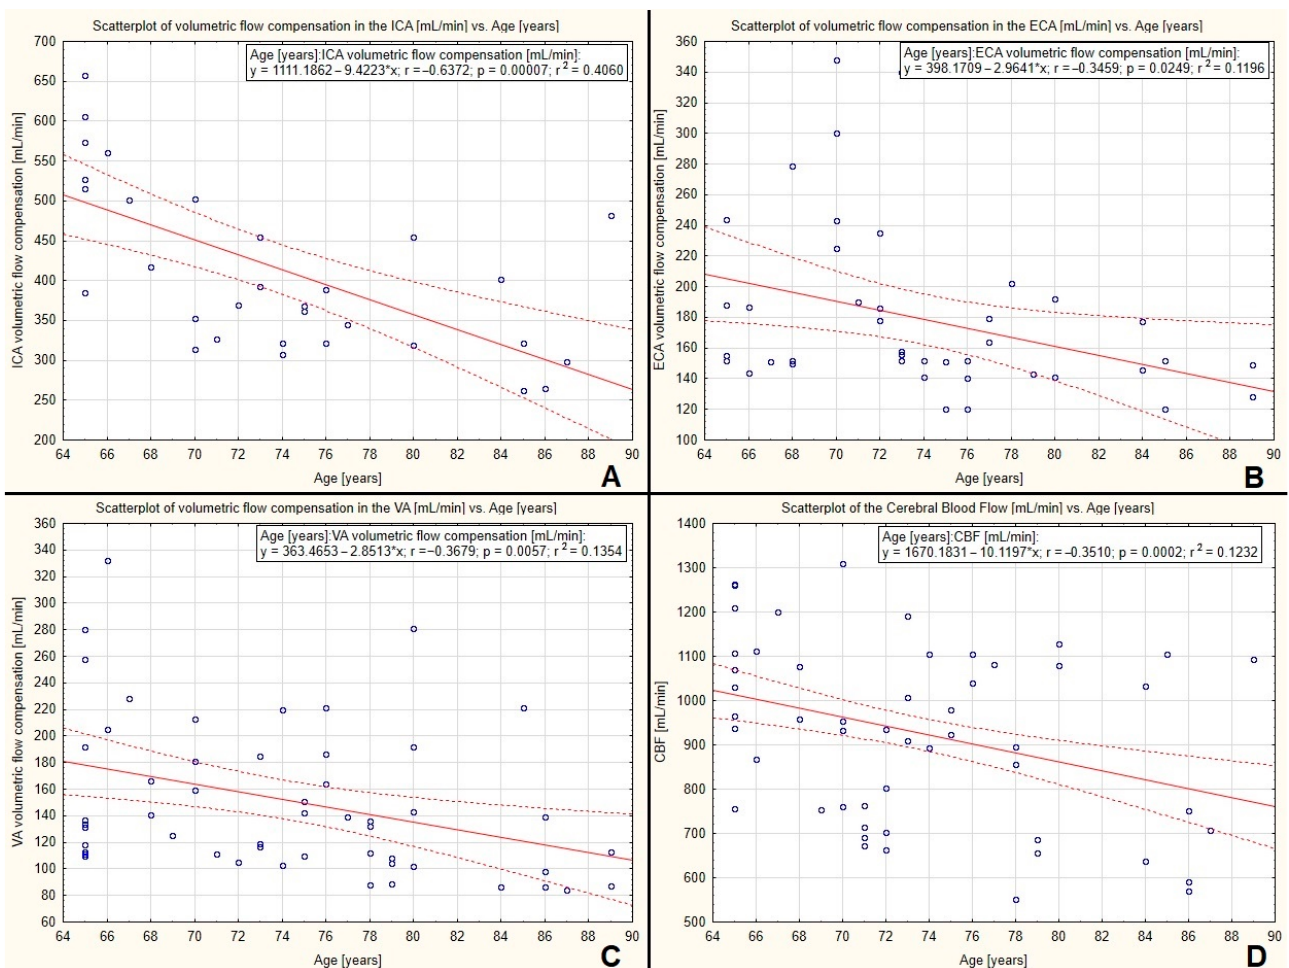
Figure 7. Regression analysis between blood flow volume in extracranial vessels with compensatory increased flow: ICA ( A ), ECA ( B ), VA ( C ), and CBF ( D ) with age. A significant decreasing correlation between blood flow volume in the ICA, ECA, and VA was observed—( A ), ( B ) and ( C ), respectively. This may explain the significant decreasing correlation between the CBF and increasing age ( p = 0.0002), which is presented here once again—( D ) (also Figure 6D).